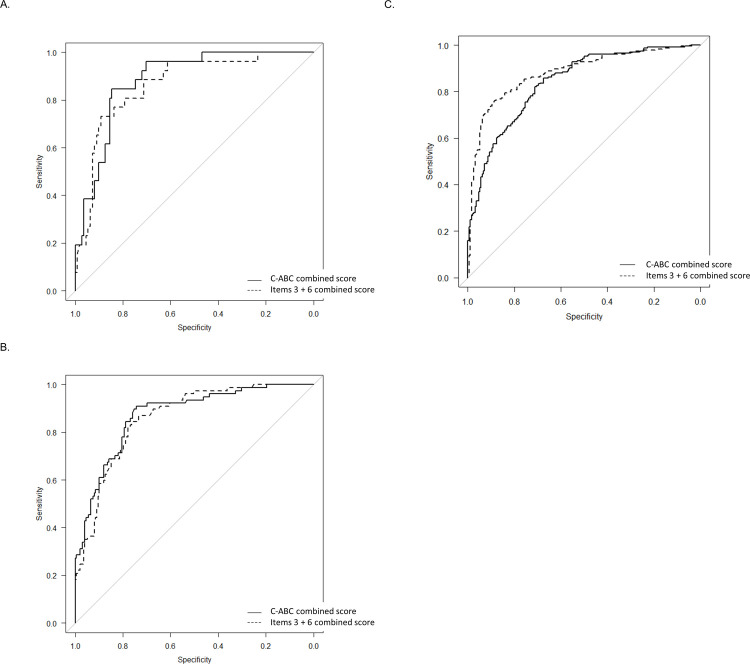
The ROC curves to distinguish dementia from MCI and NC in the 50s group (A), 60s group (B), and 70–85 group (C). Straight line, the C-ABC combined score; dotted line, the Item 3 + 6 combined score. C-ABC, computerized assessment battery for cognition; MCI, mild cognitive impairment; NC, normal cognition; ROC, receiver-operating characteristic.